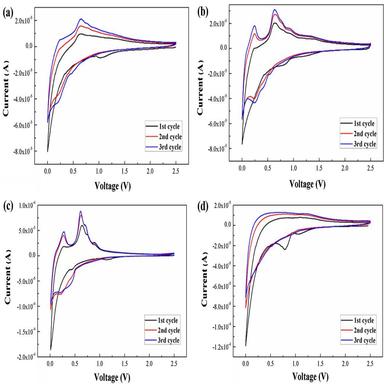
Cyclic voltammetry curves of SnSb@CMFs-1 (a), SnSb@CMFs-2 (b), SnSb@CMF-2@C (c), and CMFs (d).